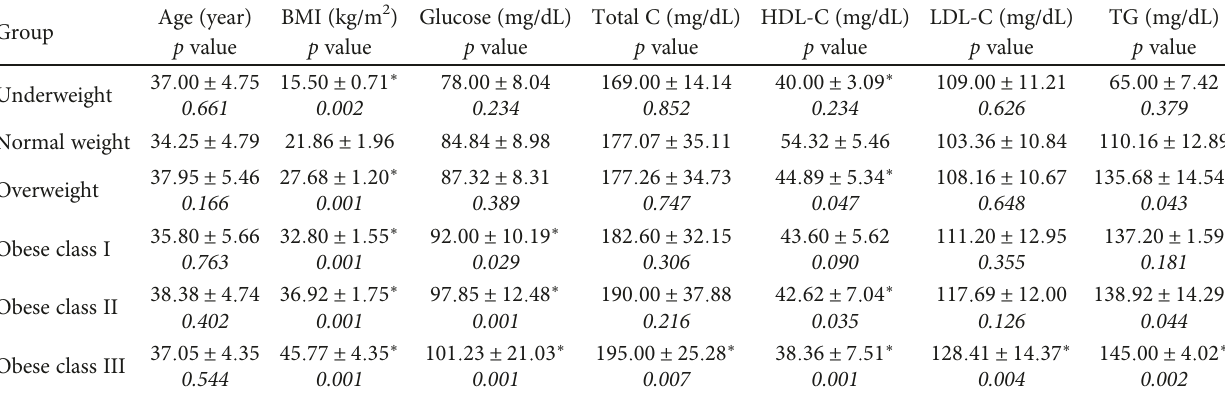
Table 1: Comparison of age, BMI, glucose, and lipid pro fi les of the